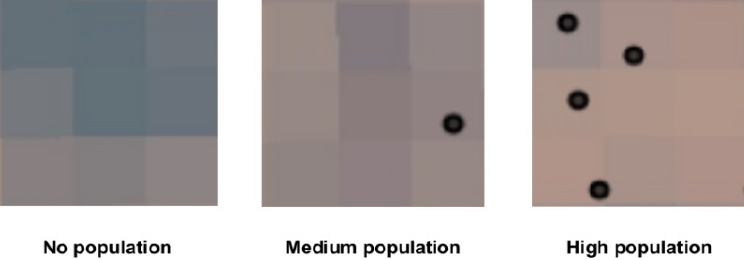
Fig. 4. RGB representation of satellite image grid cells and corresponding